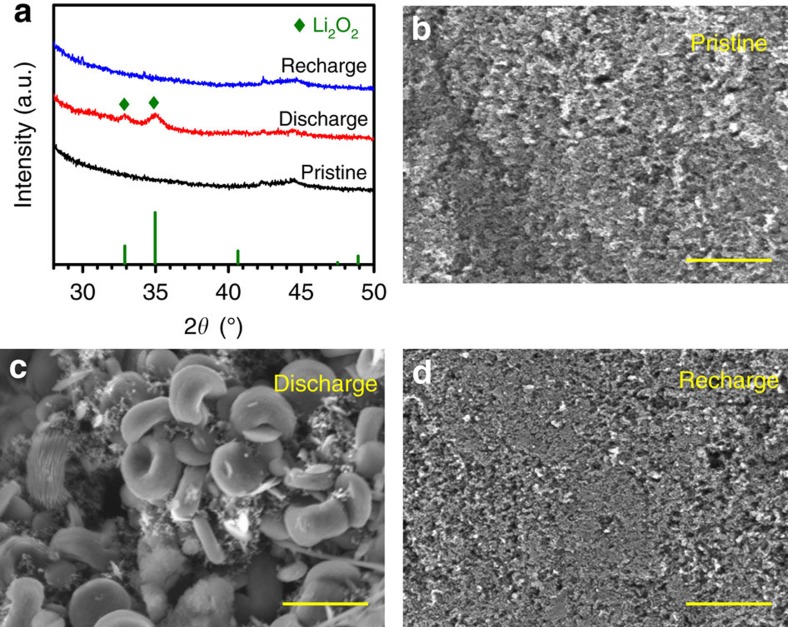
Discharge products on the cathode of a Li-O2 cell in the G4-UH2O2 electrolyte.(a) XRD patterns of the pristine, discharged and recharged cathodes. SEM images of (b) the pristine cathode, (c) the discharged cathode and (d) the recharged cathode. The discharge products are identified as Li2O2 with typical toroid morphology. Scale bar, 2 μm.